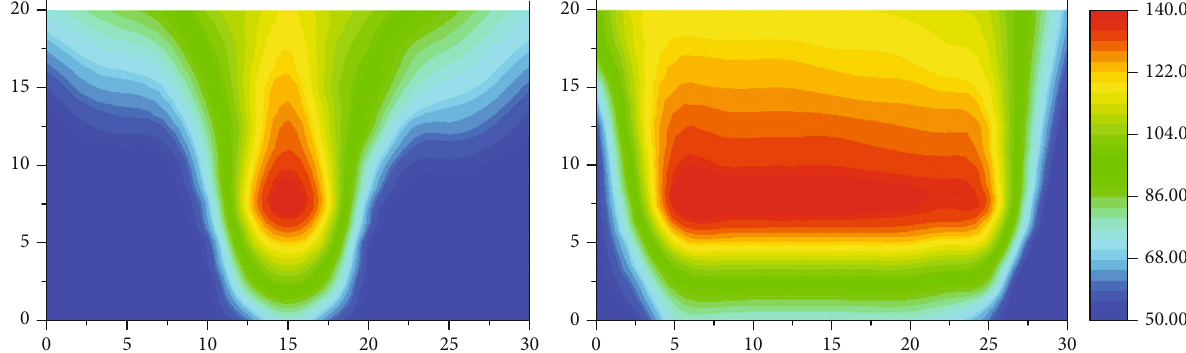
Figure 5: Temperature fi eld in the 3D model during the middle stage of Experiment 1: (a) in the vertical direction of the wells and (b) along the wells.